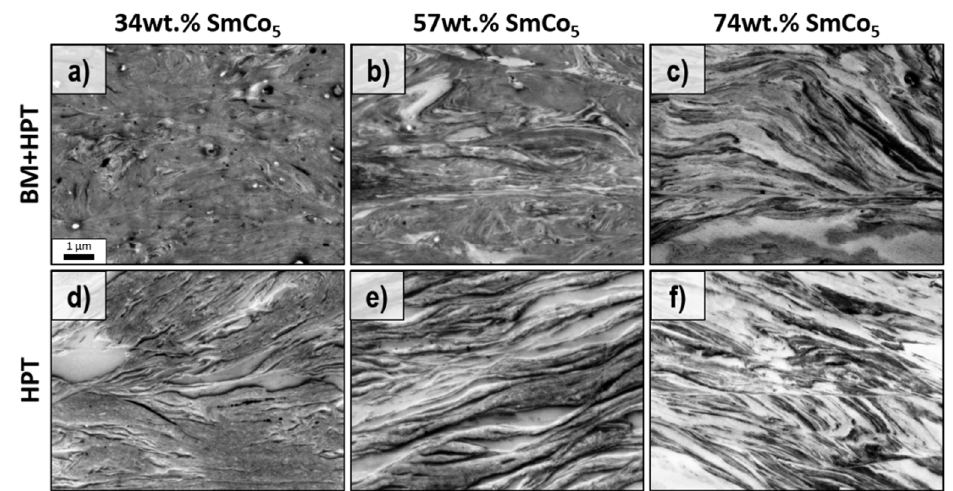
Figure 4. BSE images of ball-milled and HPT-deformed powder samples ( a – c ) and un-milled and HPT deformed powder samples ( d – f ) in tangential direction with 34 ( a , d ), 57 ( b , e ) and 74 wt.% SmCo 5 ( c , f ). The scale bar in ( a ) also applies to all other images.